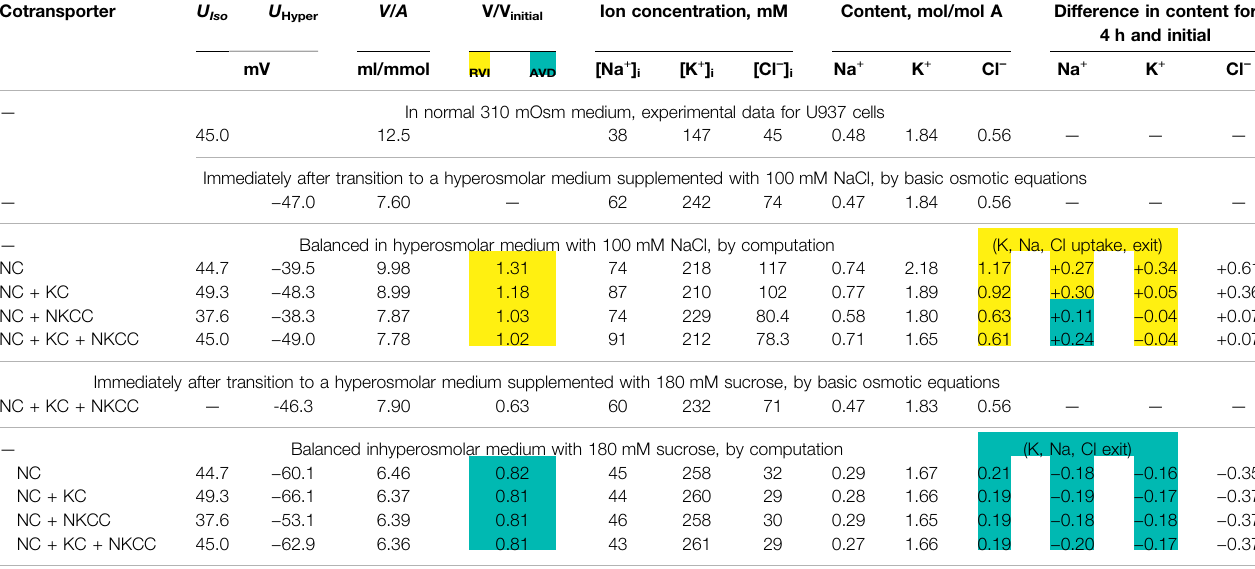
TABLE 3 | Changes in ionic homeostasis under new balanced state in hyperosmolar media with 100 mM NaCl or 180 mM sucrose, calculated for the U937 cell model with different sets of cotransporters and parameters corresponding to cells balanced with normal 310 mOsm medium. Cotransporter U Iso V/A V/V initial Ion concentration, mM Content, mol/mol A Difference in content for